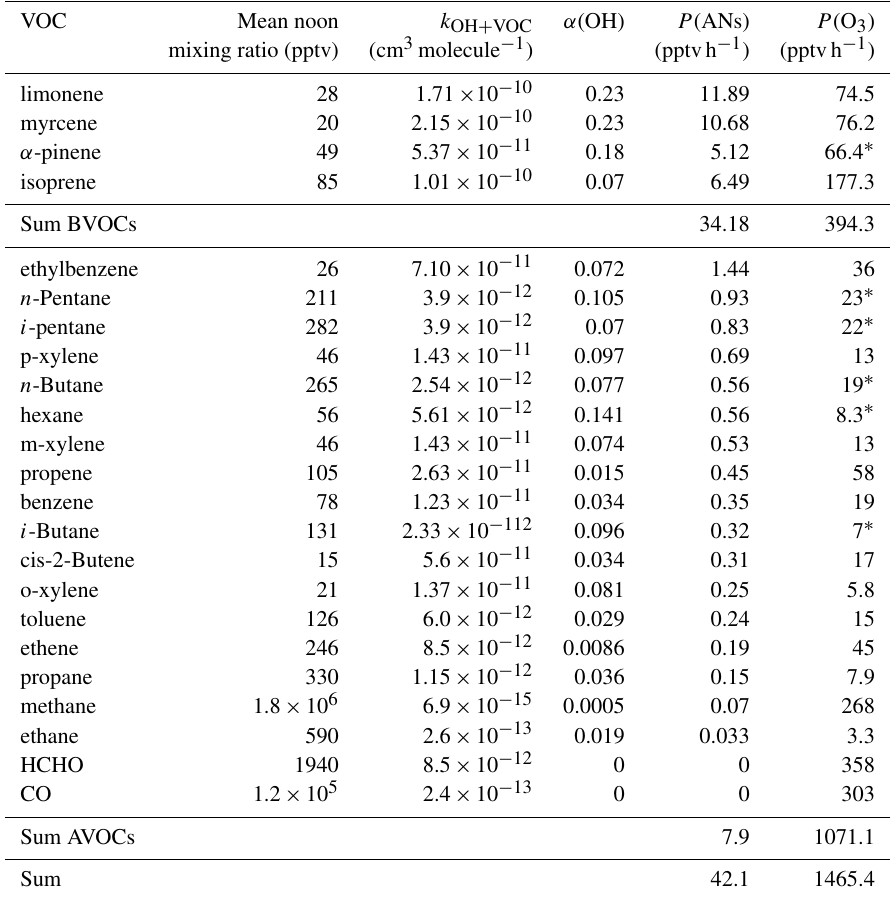
Table 1. VOCs measured during the PARADE campaign by GC-MS–FID.